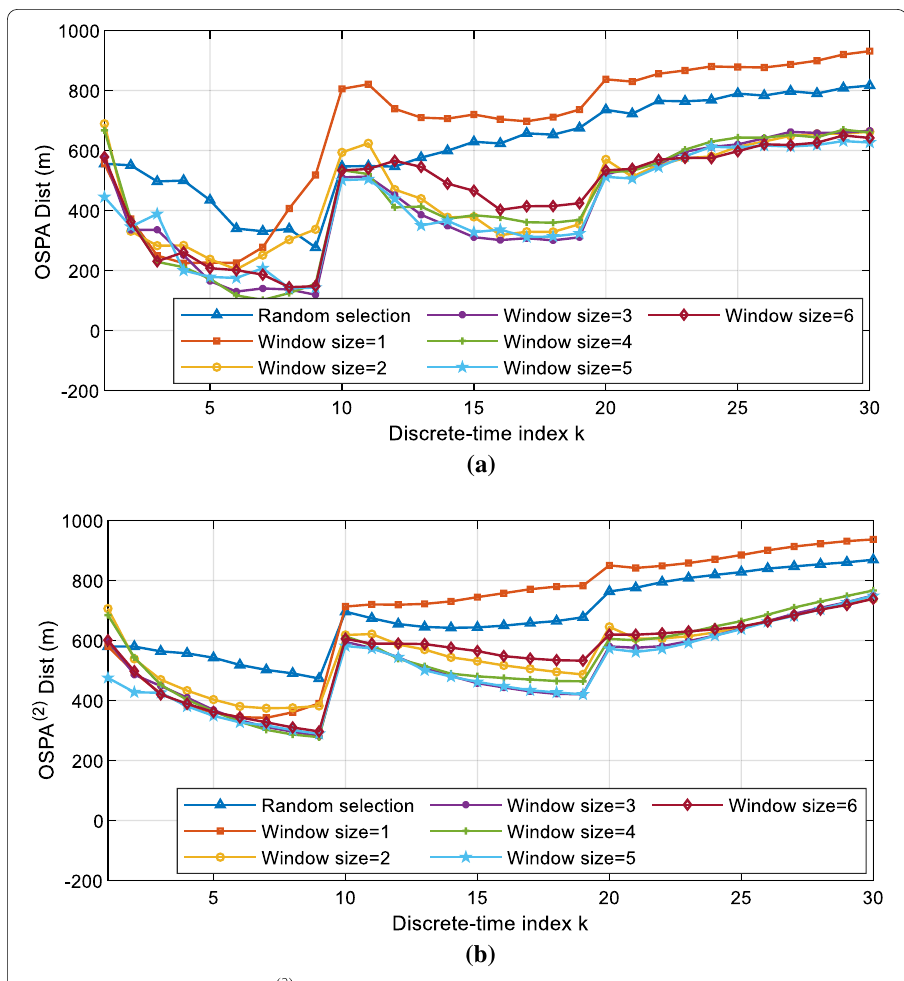
Fig. 7 Average OSPA and OSPA ( 2 ) errors in multi-target